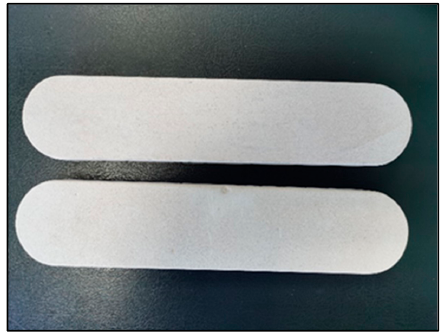
Figure 10. Artificial high salinity slab.